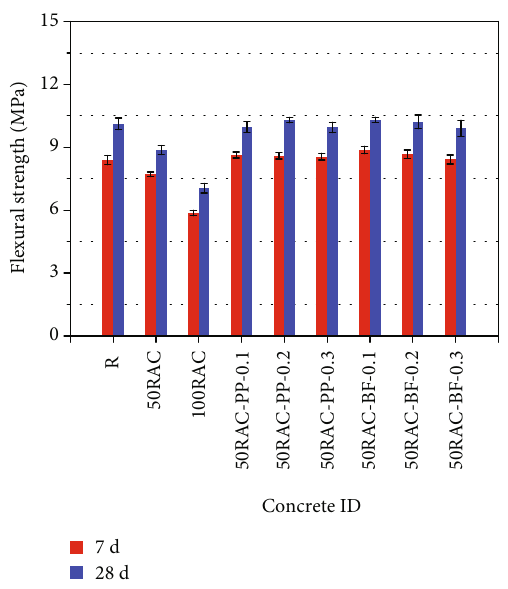
Figure 8: Flexural strength of concrete.